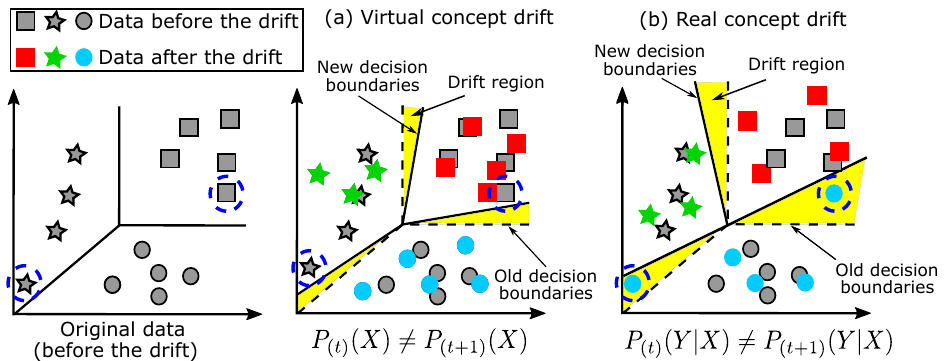
Figure 8. Example of the concept drift phenomenon. The left panel shows the original data before the drift, which is in gray, and it consists of three classes; each has a different shape. After two types of drift (in a , b ), the new data points are colored, and the data distributions are changed. ( a ) Virtual drift: the changes are in the distribution of the data points ( P ( t ) ( X ) (cid:54) = P ( t + 1 ) ( X ) ). ( b ) Real drift: The changes are in the posterior probability ( P ( t ) ( Y | X ) (cid:54) = P ( t + 1 ) ( Y | X ) ); therefore, the class labels of some historical points (the two highlighted instances with blue dashed circles) are changed. The shaded yellow area between the old decision boundaries (dashed lines) and the new decision boundaries (solid lines) illustrates the changes in the decision boundaries before and after the